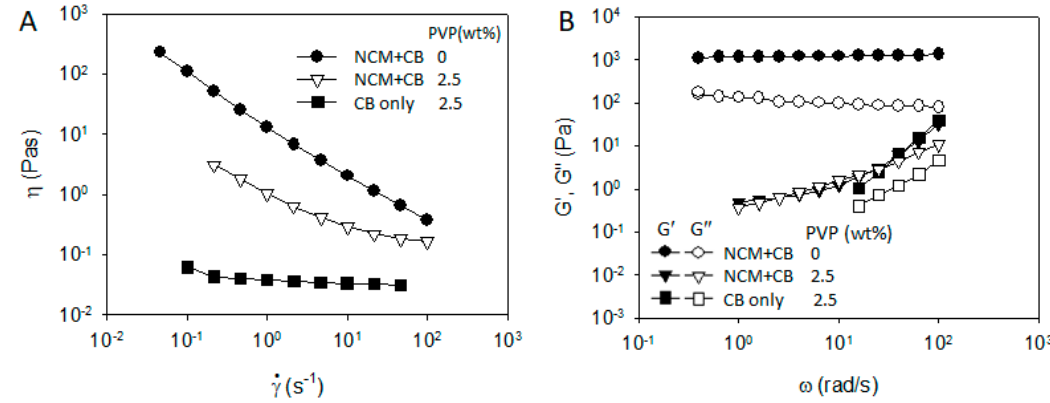
Figure 9. ( A ) Steady shear viscosity and ( B ) frequency dependent storage and loss modulus of NCM/CB/PVP/NMP mixtures of 60 wt% (=25 vol%) NCM and 1.5 wt% (=1.3 vol%) CB in PVDF/NMP solution at φ PVDF = 2.5 wt%.